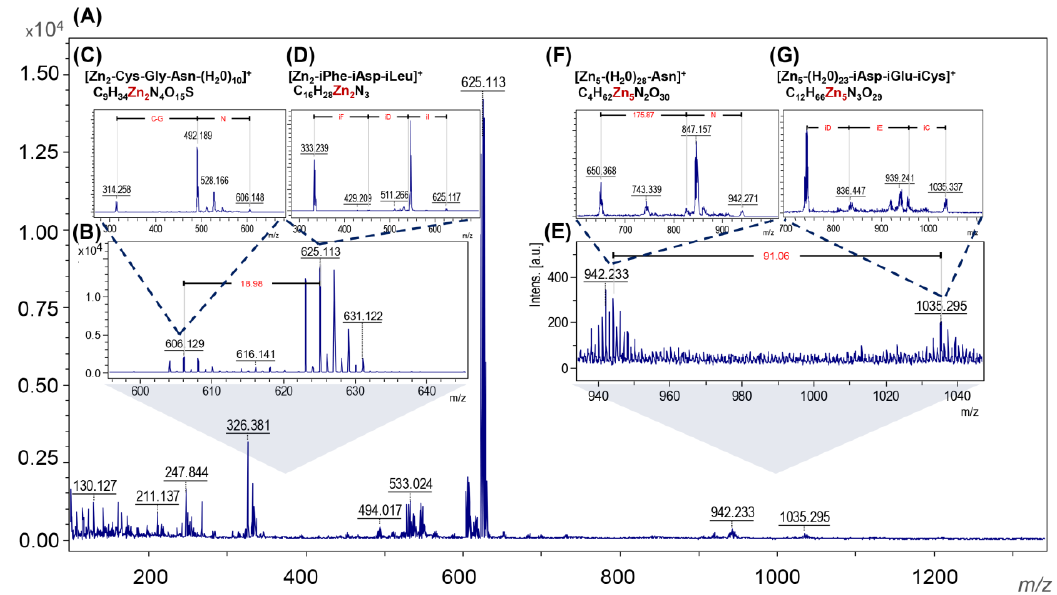
Figure 4. The molecular fingerprint of biologically synthesized ZnO NCs ( A ); the MS/MS spectra for specific signals ( B – G ).